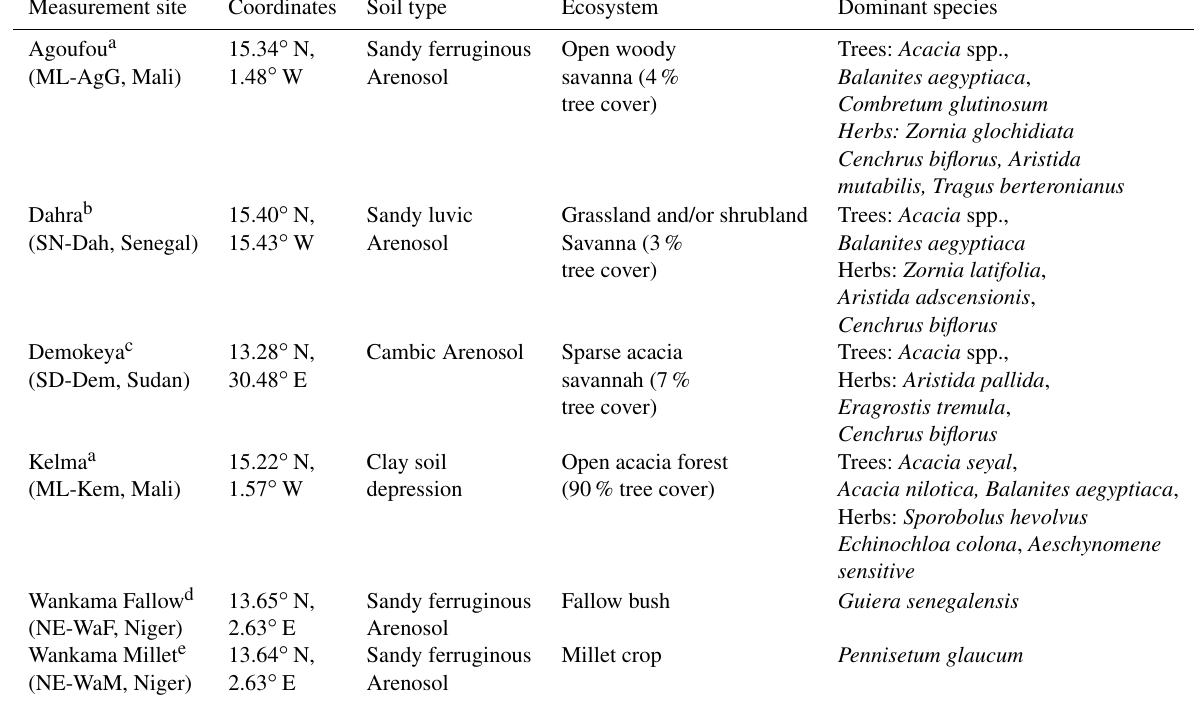
Table 1. Description of the six measurement sites, including location, soil type, ecosystem type and dominant species.